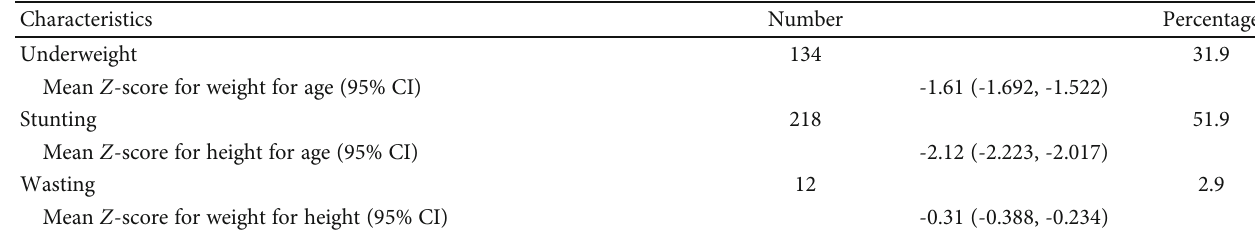
Table 4: Prevalence of nutritional status of children.